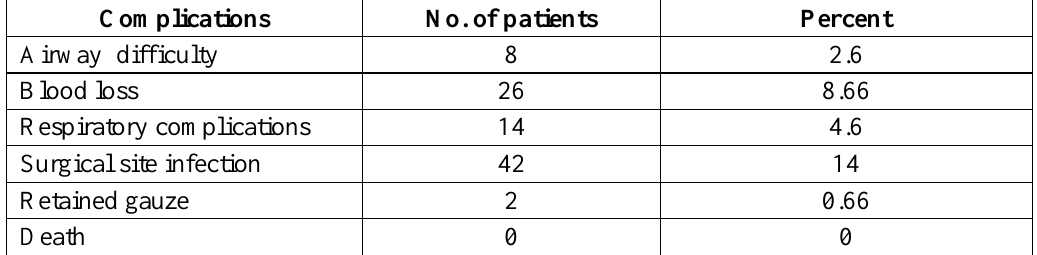
Table 5: Complications during and after completion of surgery (N=300)